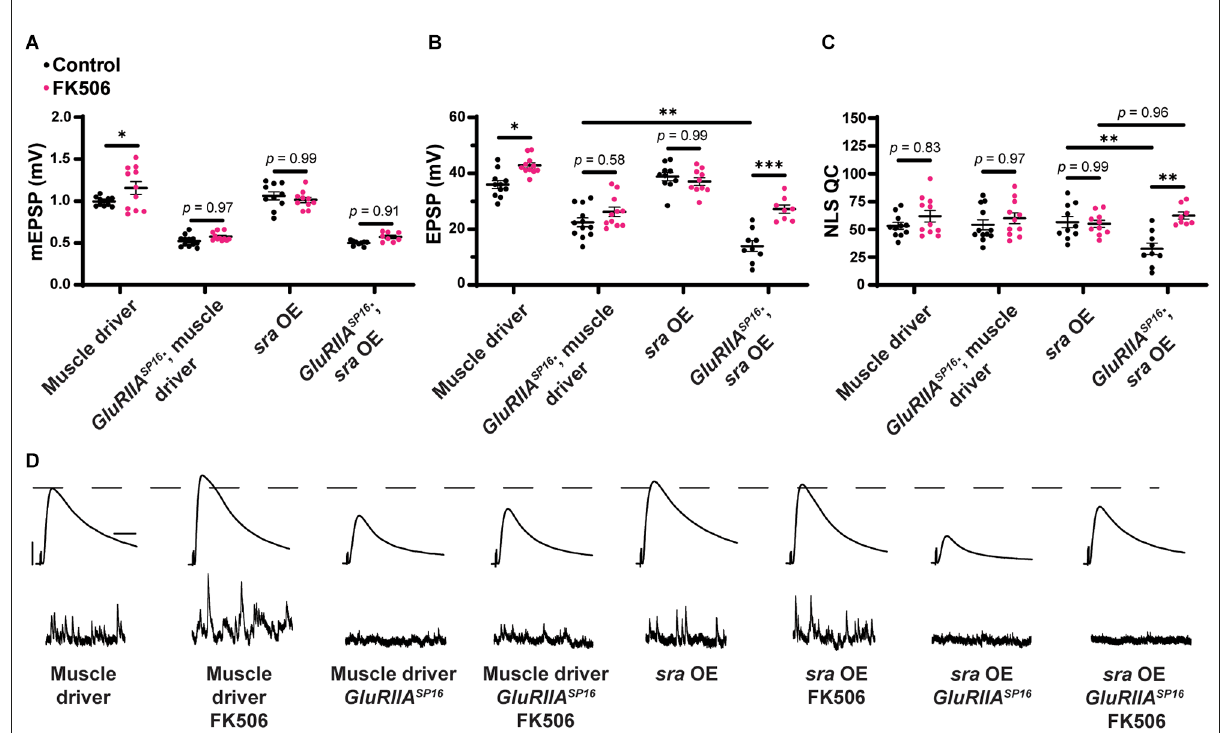
FIGURE9 Pharmacological inhibition of calcineurin partially rescues the PHP deficit observed in chronically challenged postsynaptic overexpression of sra animals. (A–C) Quantification showing average mEPSP amplitude, EPSP amplitude, and NLS quantal content in post-GAL4 control and post-GAL4 driven sra overexpression (OE) in both the presence and absence of 50 µ M FK506. Black points show DMSO control synapses while dark pink points represent 50 µ M FK506. (D) Representative electrophysiological traces of EPSPs (above) and mEPSPs (below). Scale bars for all traces are